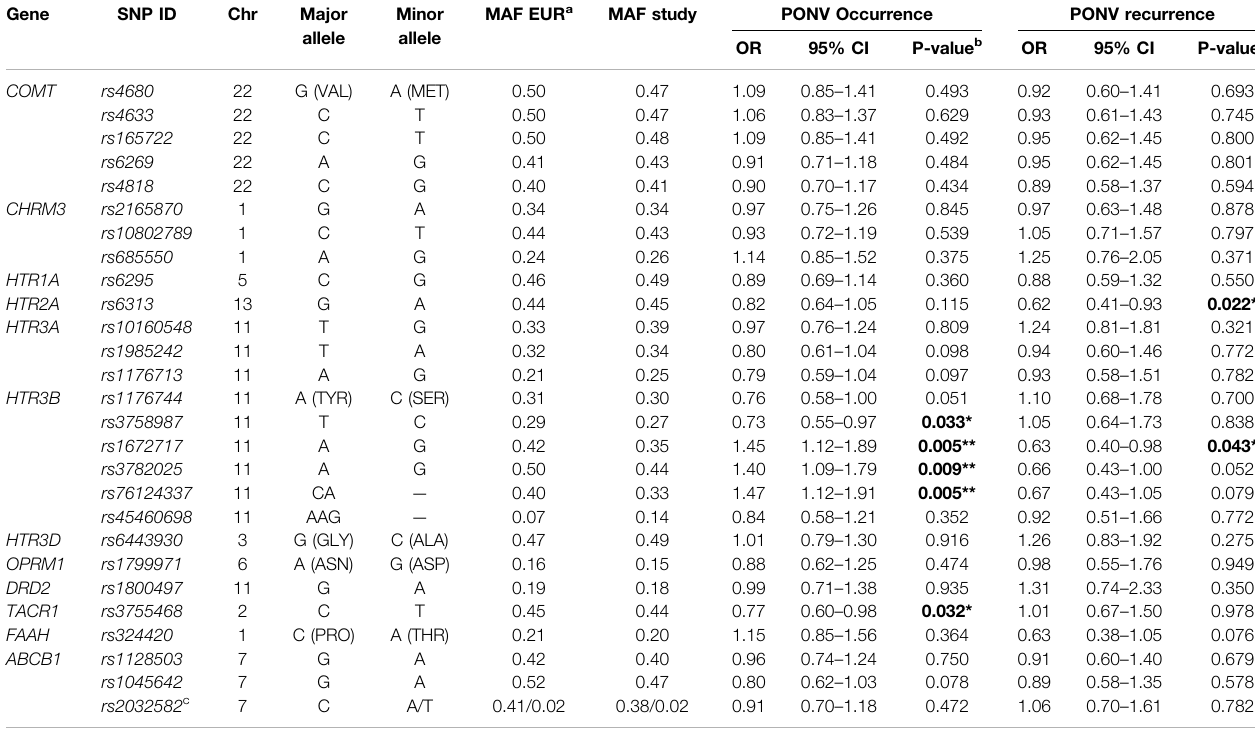
TABLE 2 | Correlation between PONV and selected single nucleotide polymorphisms. Gene SNP ID Chr